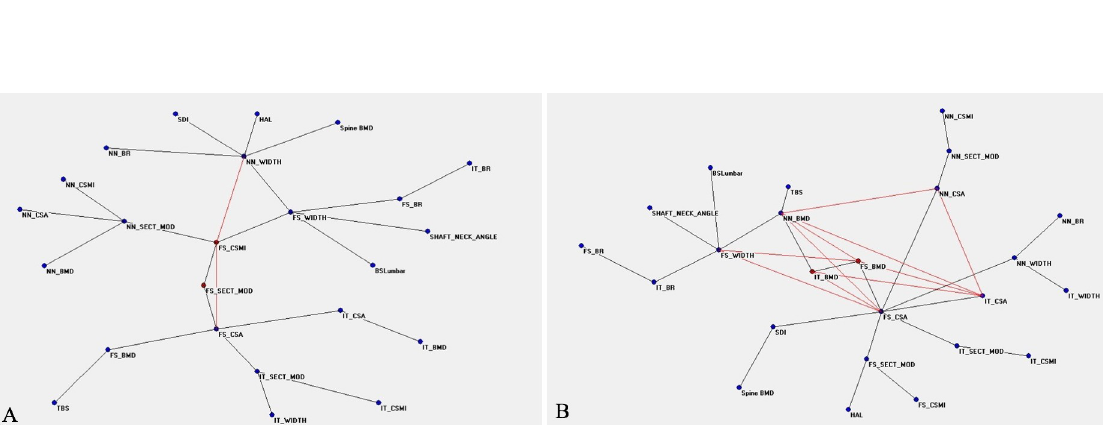
Fig 3. Semantic map showing the relations between the investigated anagraphic, anthropometric, densitometric, biochemical and clinical parameters in the “responders” before treatment (a) and after treatment (b).